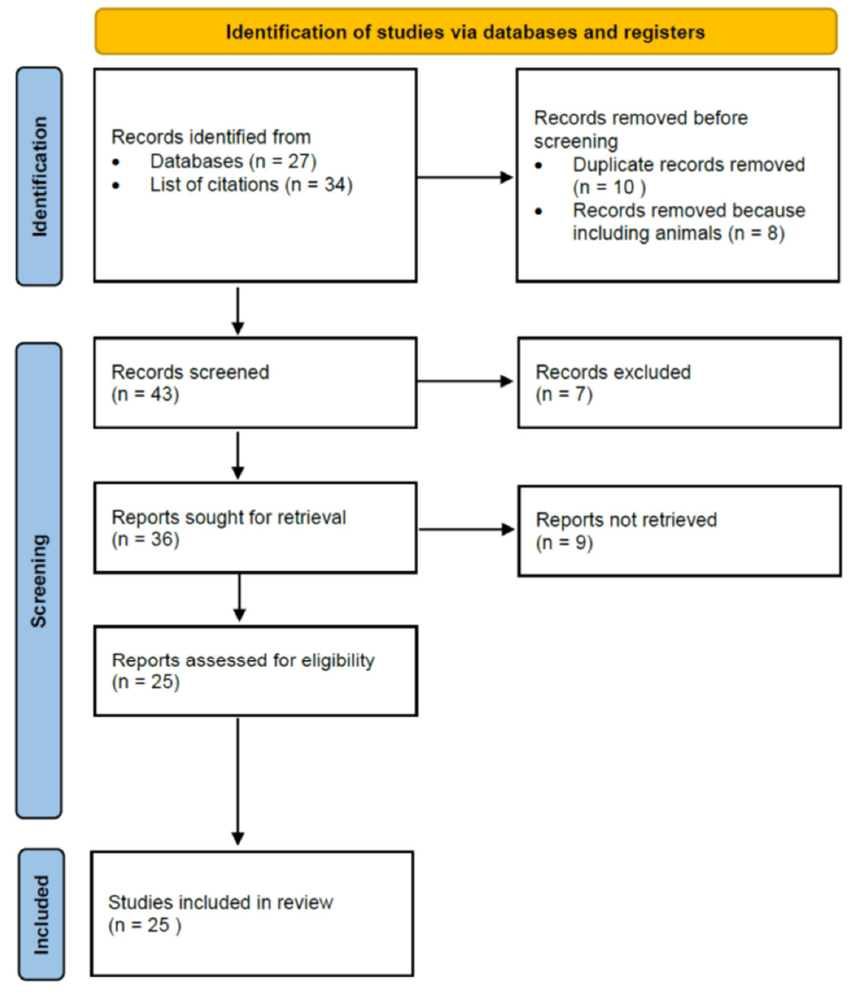
Figure 1. PRISMA flow diagram. Association of endocrine-disrupting chemicals—bisphenols, phthalates, and parabens—with human semen quality and oxidative stress.